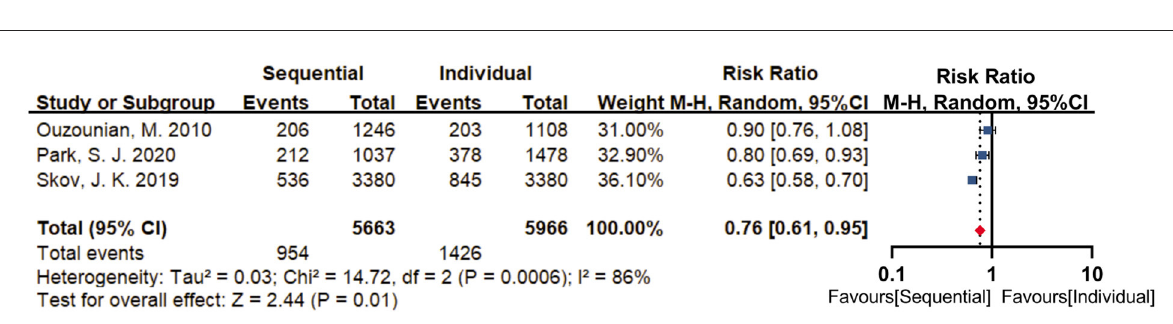
FIGURE6 Forest plot for long-term mortality. Three studies reported long-term mortality ( > 5 years), with a high statistical heterogeneity between the included studies (I 2 = 86%, P = 0.0006). By using a random-effect model, results revealed that sequential group (16.8%) was with a lower risk of long-term mortality (RR = 0.76; 95% CI, 0.61–0.95, P = 0.01) compared with individual group